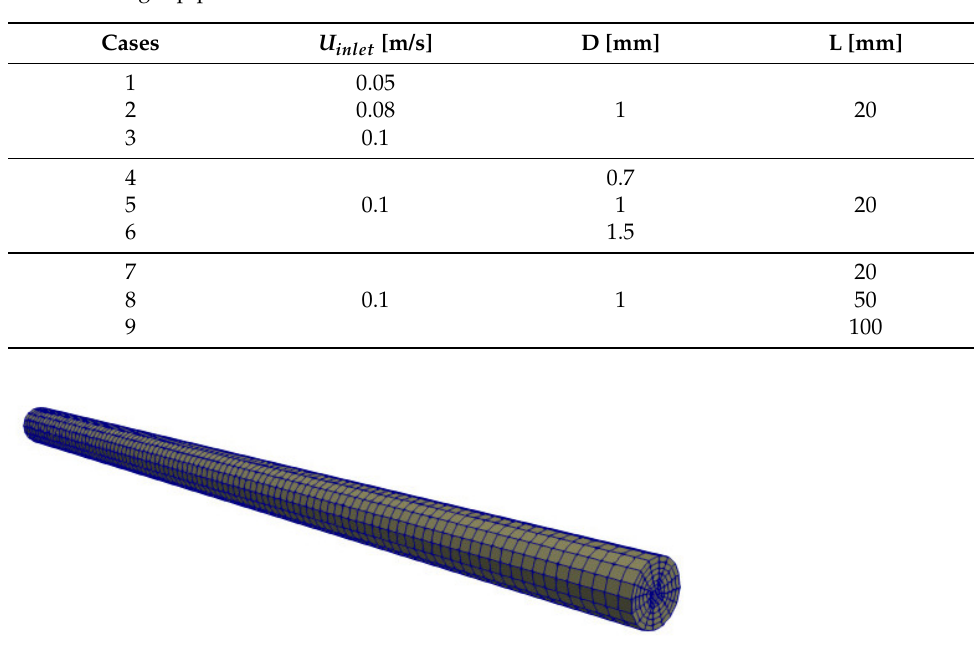
Table 5. Straight pipe: case definitions.